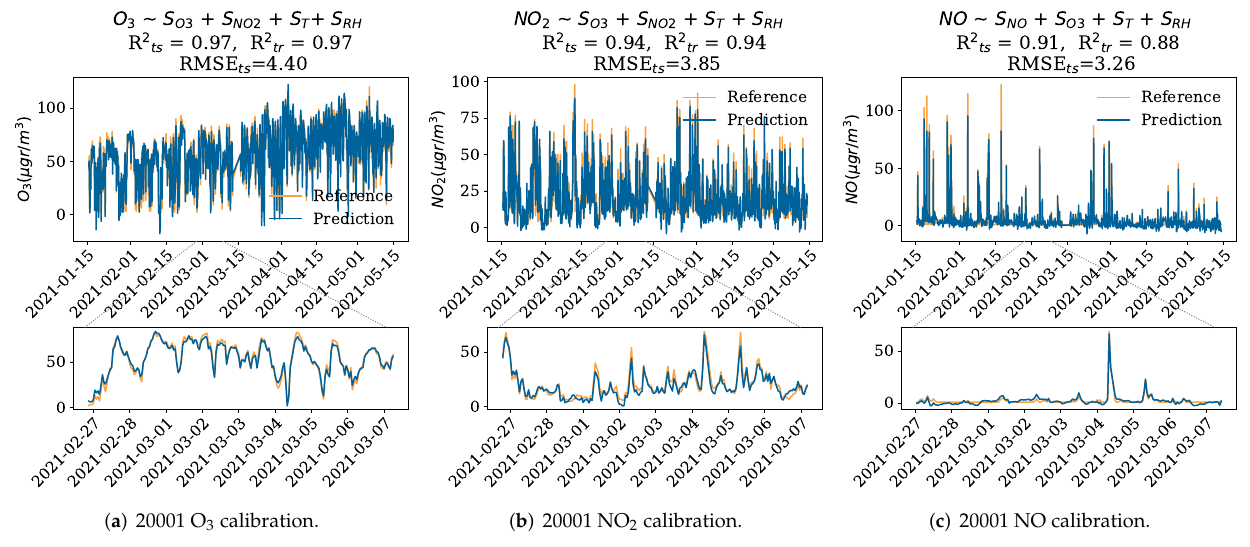
Figure 4. Calibration results for the O 3 , NO 2 and NO sensor of Captor nodes 20001 and 20002. R 2 ts and R 2 tr denote the training and testing coefficient of determination, while RMSE ts denotes the root-mean-squared error for the testing using MLR. Bottom plots are a zoom of the plots above for a specific time